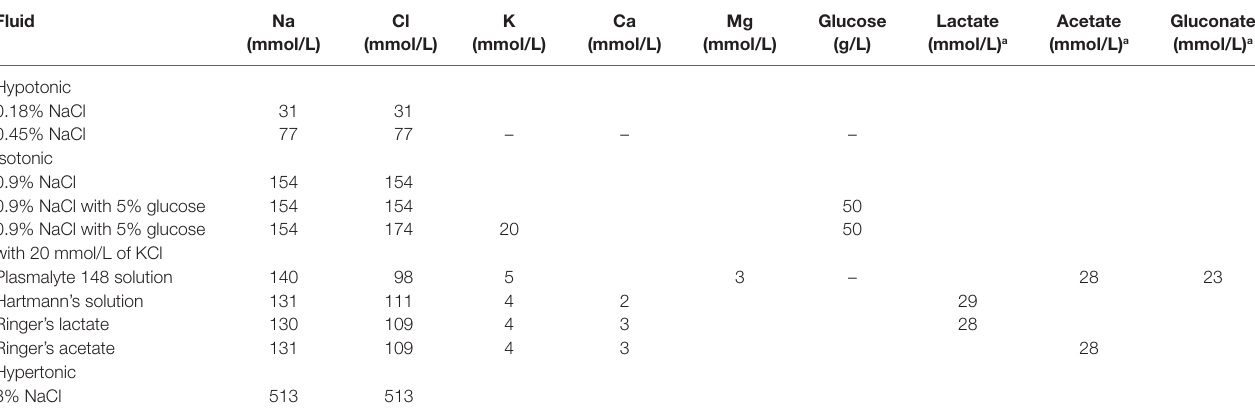
TABLe 7 | Some examples of hypotonic, isotonic, and hypertonic fluids (16,